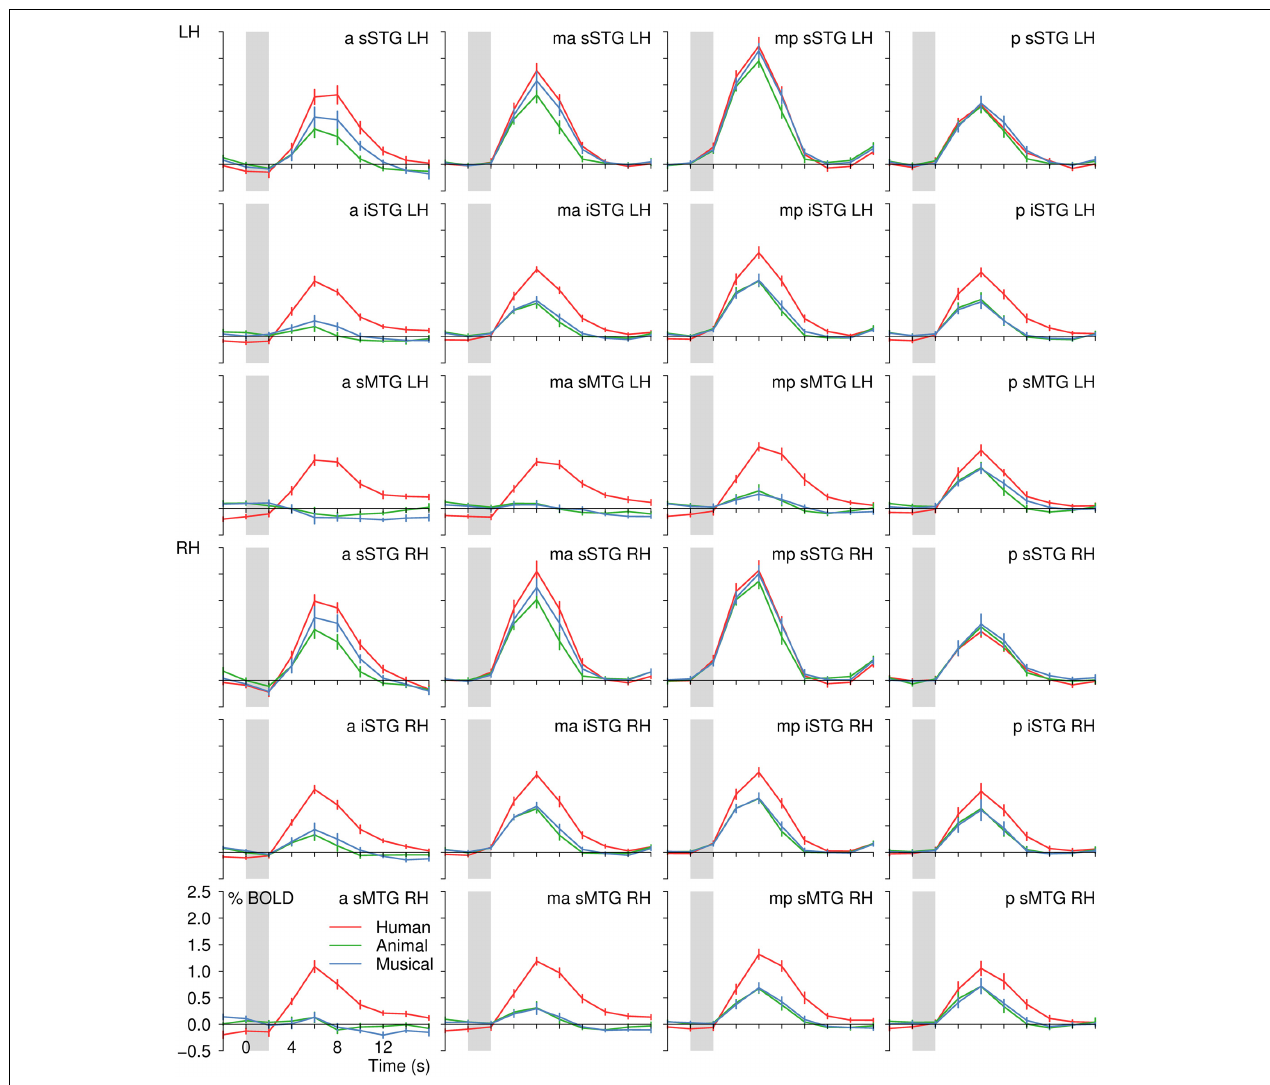
FIGURE 8 | BOLD signal time courses in all regions of interest of the left (LH) and right (RH) temporal lobe (separate-subject analysis). For details on the location of the regions see Figure 2 and Table 1 . The period of stimulus presentation is indicated by gray bars.